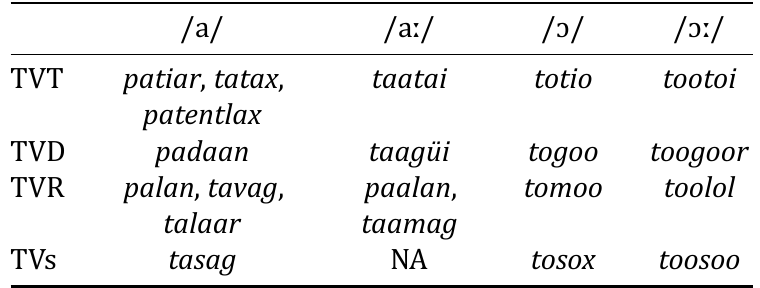
Table A.2: C₁ fortis plosive in